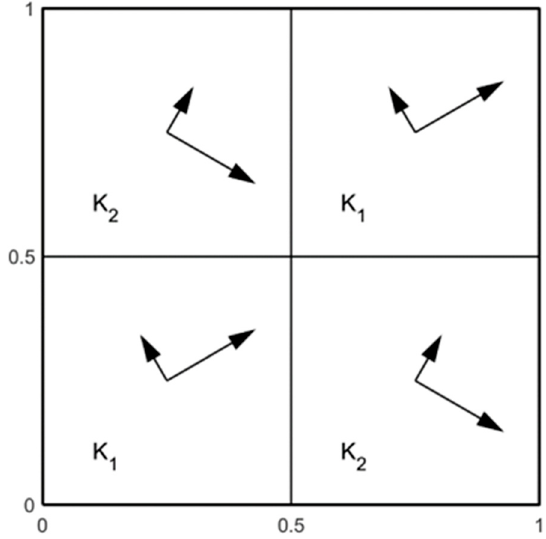
Figure 13. Discontinuous permeability field.